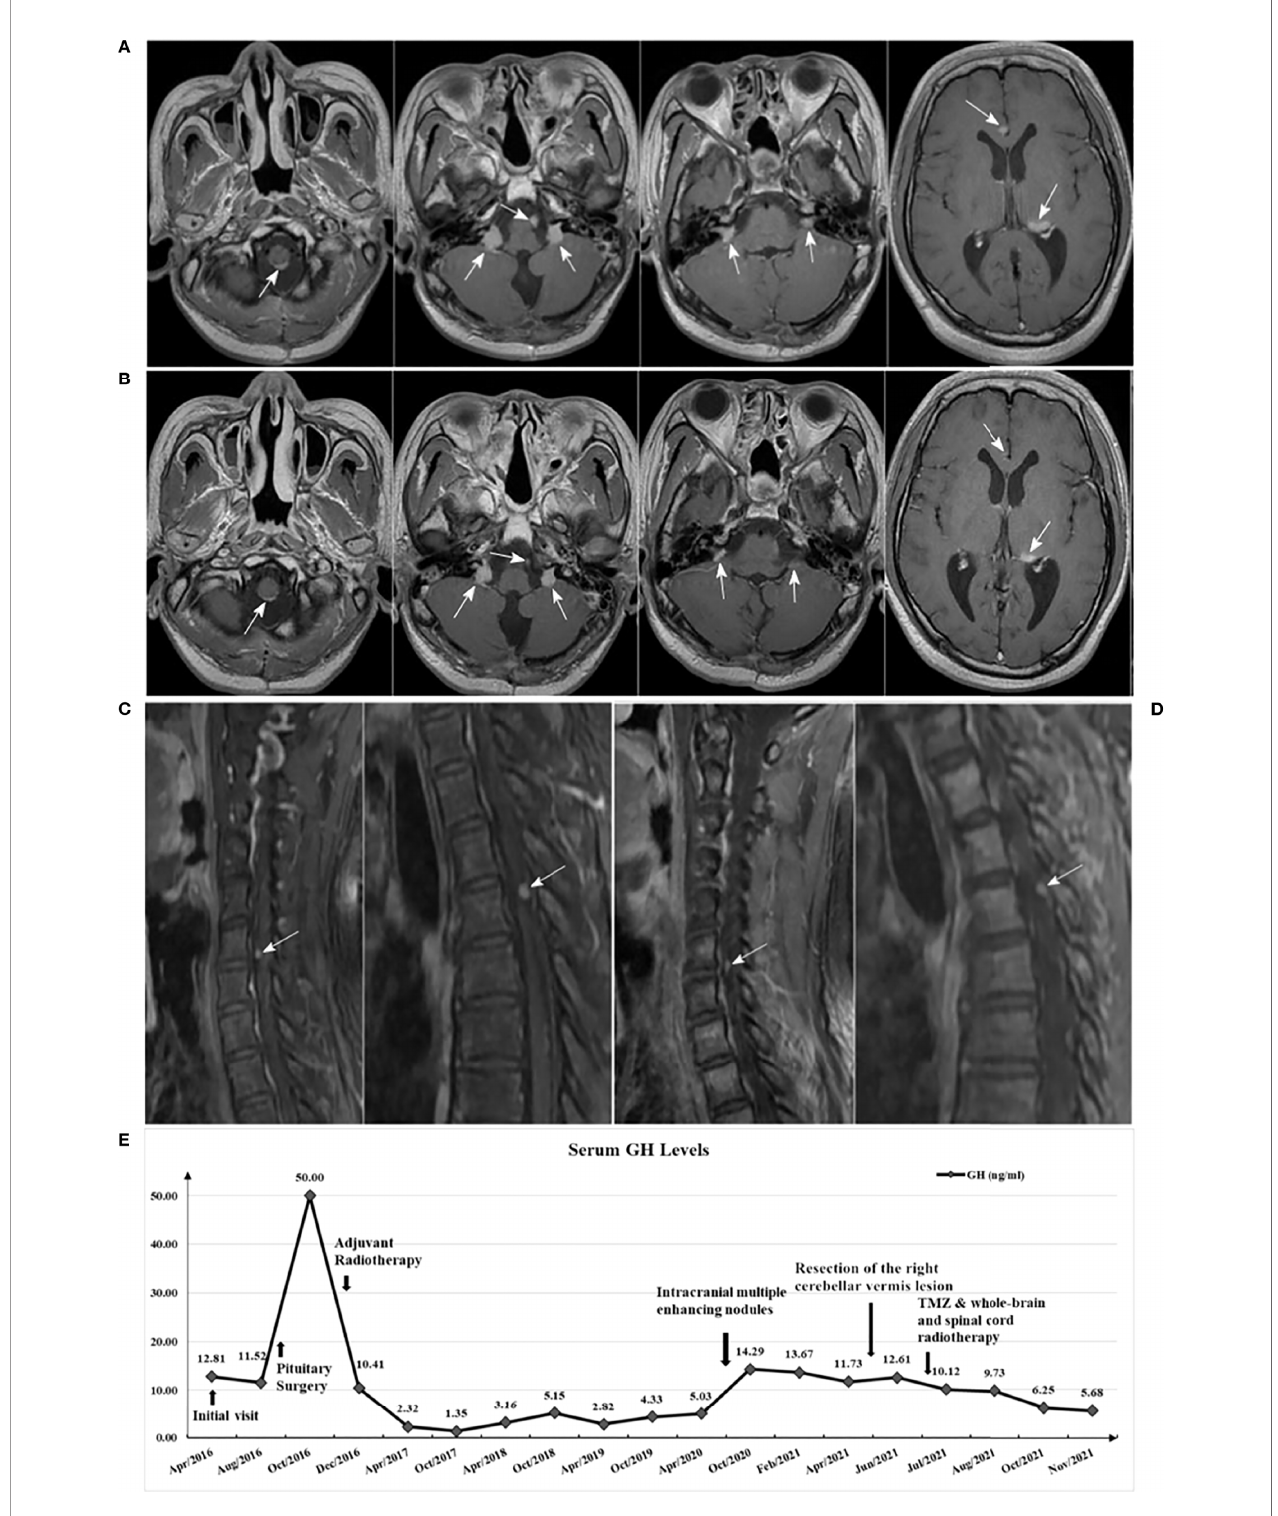
FIGURE 4 | (A) Brain enhanced MRI in May 2021 (before treatment); (B) Brain enhanced MRI in November 2021 (after treatment) showed: multiple lesions all reduced in size compared with A; (C) Spinal cord enhanced MRI in June 2021 (before treatment); (D) Spinal cord enhanced MRI in November 2021 (after treatment) showed: enhanced nodules in the sixth cervical vertebrae and fourth thoracic vertebral plane of the spinal cord both mildly decreased compared with C; (E) Serum GH levels variation curve of the patient.